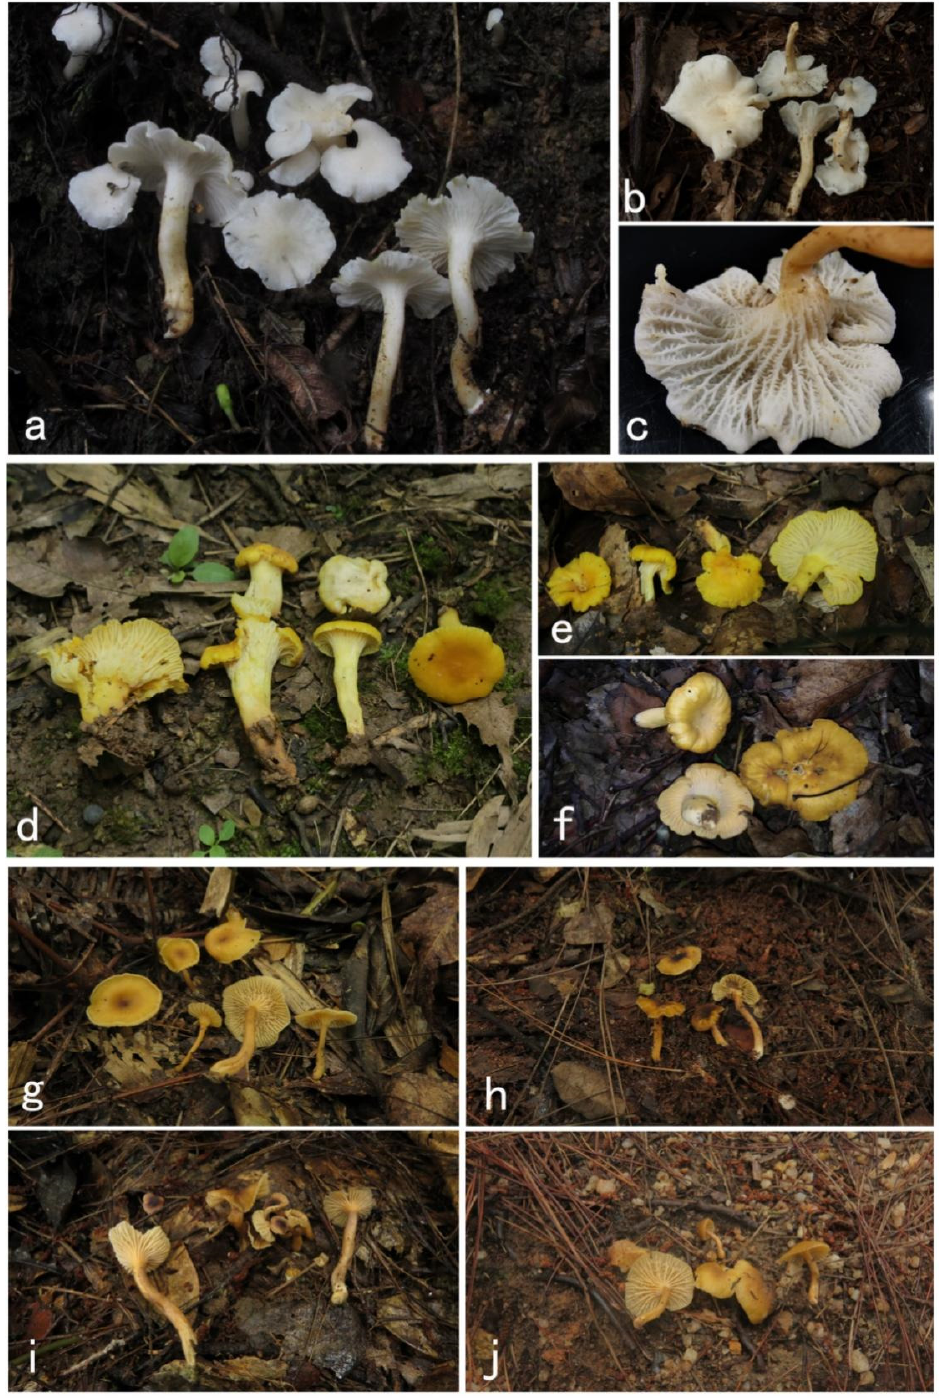
Figure 3. Species of Cantharellus subg. Parvocantharellus from China. ( a – c ) C. albus ( a ) GDGM56646; ( b ) GDGM73460; ( c ) GDGM81399; ( d – f ) C. aurantinus ( d ) GDGM46278 holotype ( e ) GDGM46279; ( f ) GDGM81889; ( g – j ) C. austrosinensis ( g ) GDGM81249 holotype ( h ) GDGM80151; ( i ) GDGM80211; ( j ) GDGM80296.